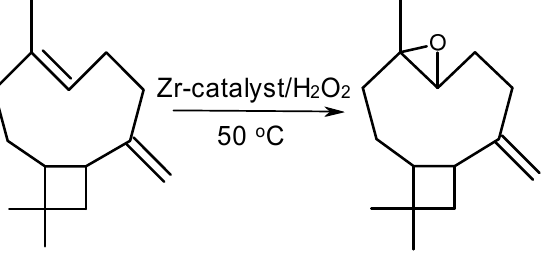
Table 4. Caryophyllene oxidation with H 2 O 2 in the presence of Zr-Si catalysts a . Catalyst